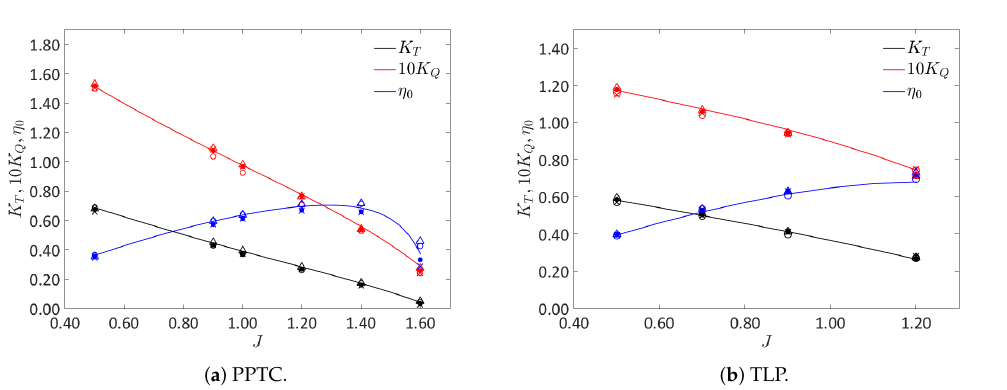
Figure 5. Open-water characteristics for the propellers. Solid lines: experimental results; • symbols denote corresponding k − ω model-scale simulations; × symbols denote EARSM model-scale simulations; (cid:52) symbols denote γ − Re θ model-scale simulations; ◦ symbols denote k − ω full-scale simulations.